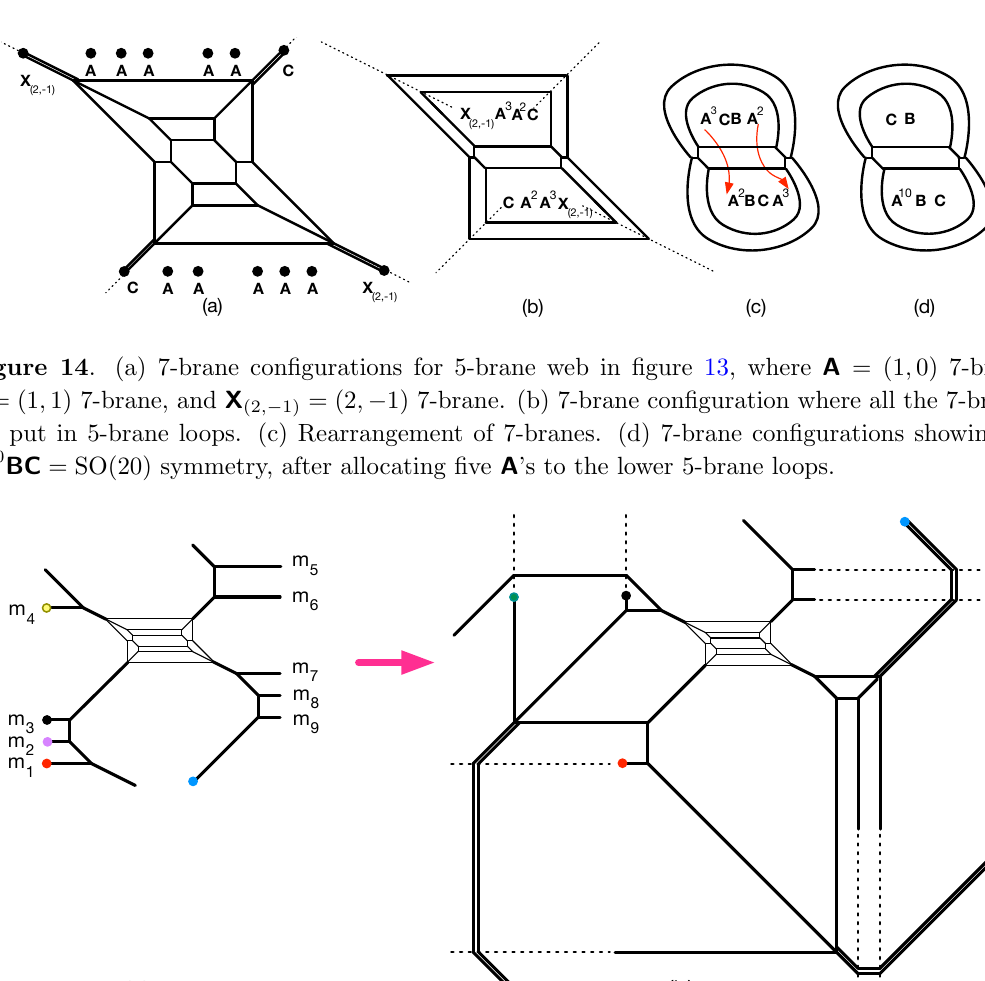
+1 TAS +9 F Tao diagram. Here we 2